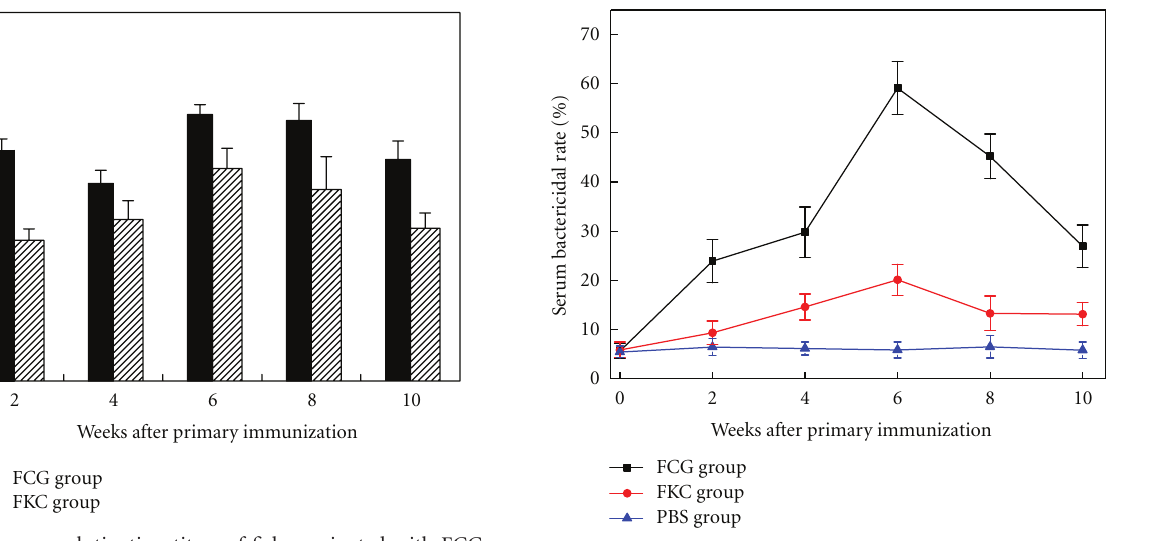
Figure 5: Serum bactericidal activities of grass carp vaccinated with FCG or FKC. The grass carp were vaccinated with FCG or FKC via intraperitoneal injection with a boost at 4 weeks after primary immunization. Serum bactericidal activities of FCG group were significantly higher than FKC group at the examined time points of postimmunization ( P < 0 .